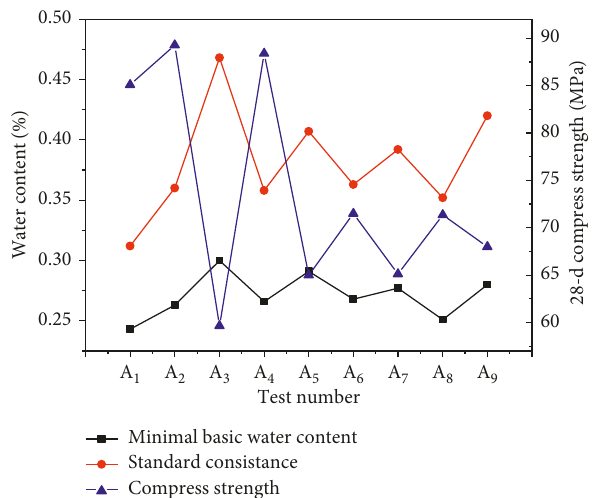
Figure 14: Water requirement, standard consistence, and com- pression strength as a function of the test